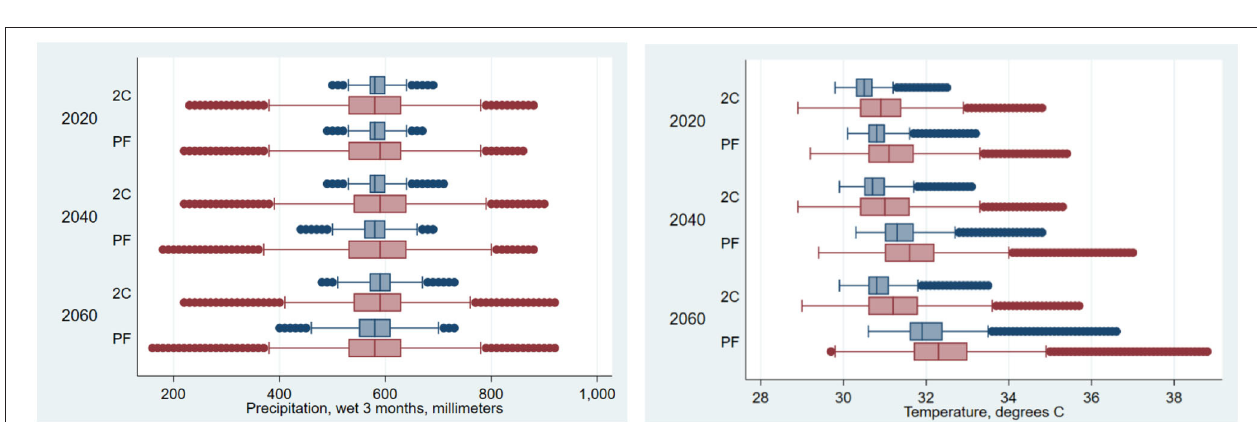
FIGURE 9 | Uncertainty and variation in future precipitation and temperature for Zambia. Source: Authors’ calculations. Values are for total precipitation during the wettest 3 months and the mean daily maximum temperature for the warmest month during the wettest 3 months of the year for each pixel, for the given decade, aggregated to the country level. For box and whisker plots, the box is bounded by the 25th and 75th percentiles, with the mid-line inside the box showing the median. The length from the 25th to the 75th percentile is called the inter-quartile range (IQR). The endpoint of the whiskers is the point that just lies within a distance of 1.5 times the IQR from the ends of the boxes. Any point beyond the whiskers is plotted individually. Blue is for the smoothed climate projections. Red is for the variation-enhanced climate